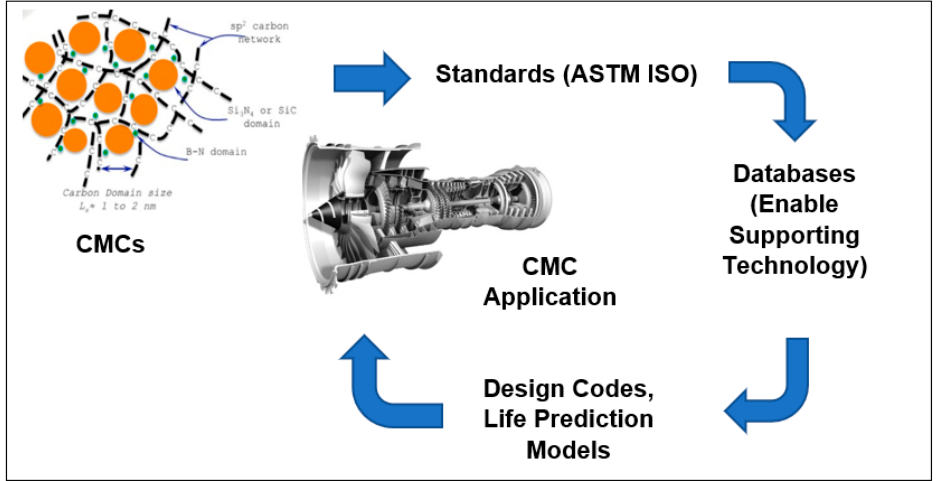
Figure 18. Interrelation of standards, databases, life expectance models, and design codes of CMCs.